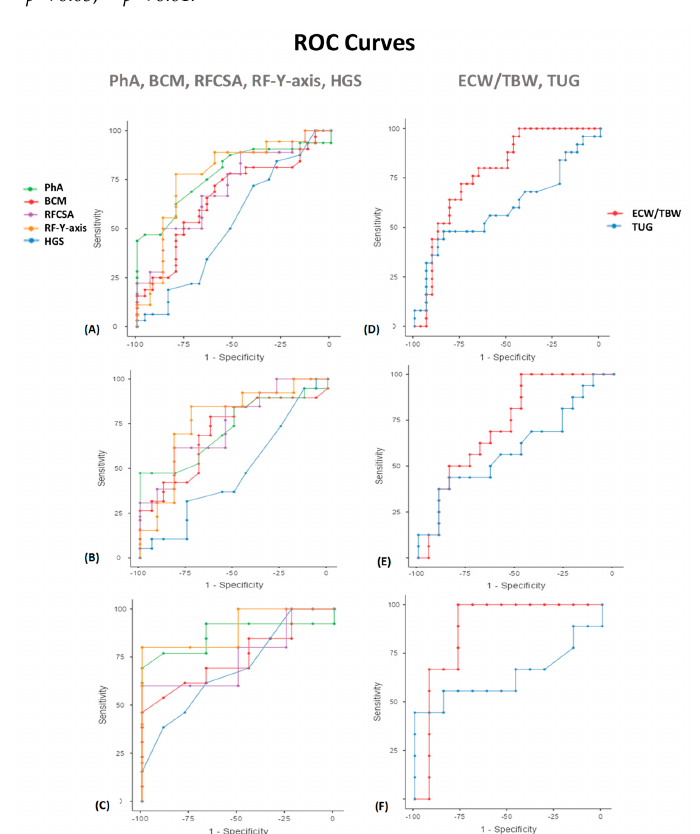
Figure 5. Area under the ROC curves (AUC) for predicting the survival at 12 months in cancer patients. PhA, BCM, RFCSA, RF-Y-axis, and HGS ( A ) Overall patients ( B ) Men ( C ) Women. ECW/TBW and TUG ( D ) Overall patients ( E ) Men ( F ) Women. ROC: receiver operating characteristic. Abbrevi- ations. PhA: phase angle; BCM: body cell mass; RFCSA: rectus femoris cross-sectional area; RF-Y- axis: rectus femoris Y axis; HGS: hand grip strength; ECW/TBW: extracellular water/total body wa- ter; TUG: Timed Up and Go test. To interpret the color references in this figure legend, please see